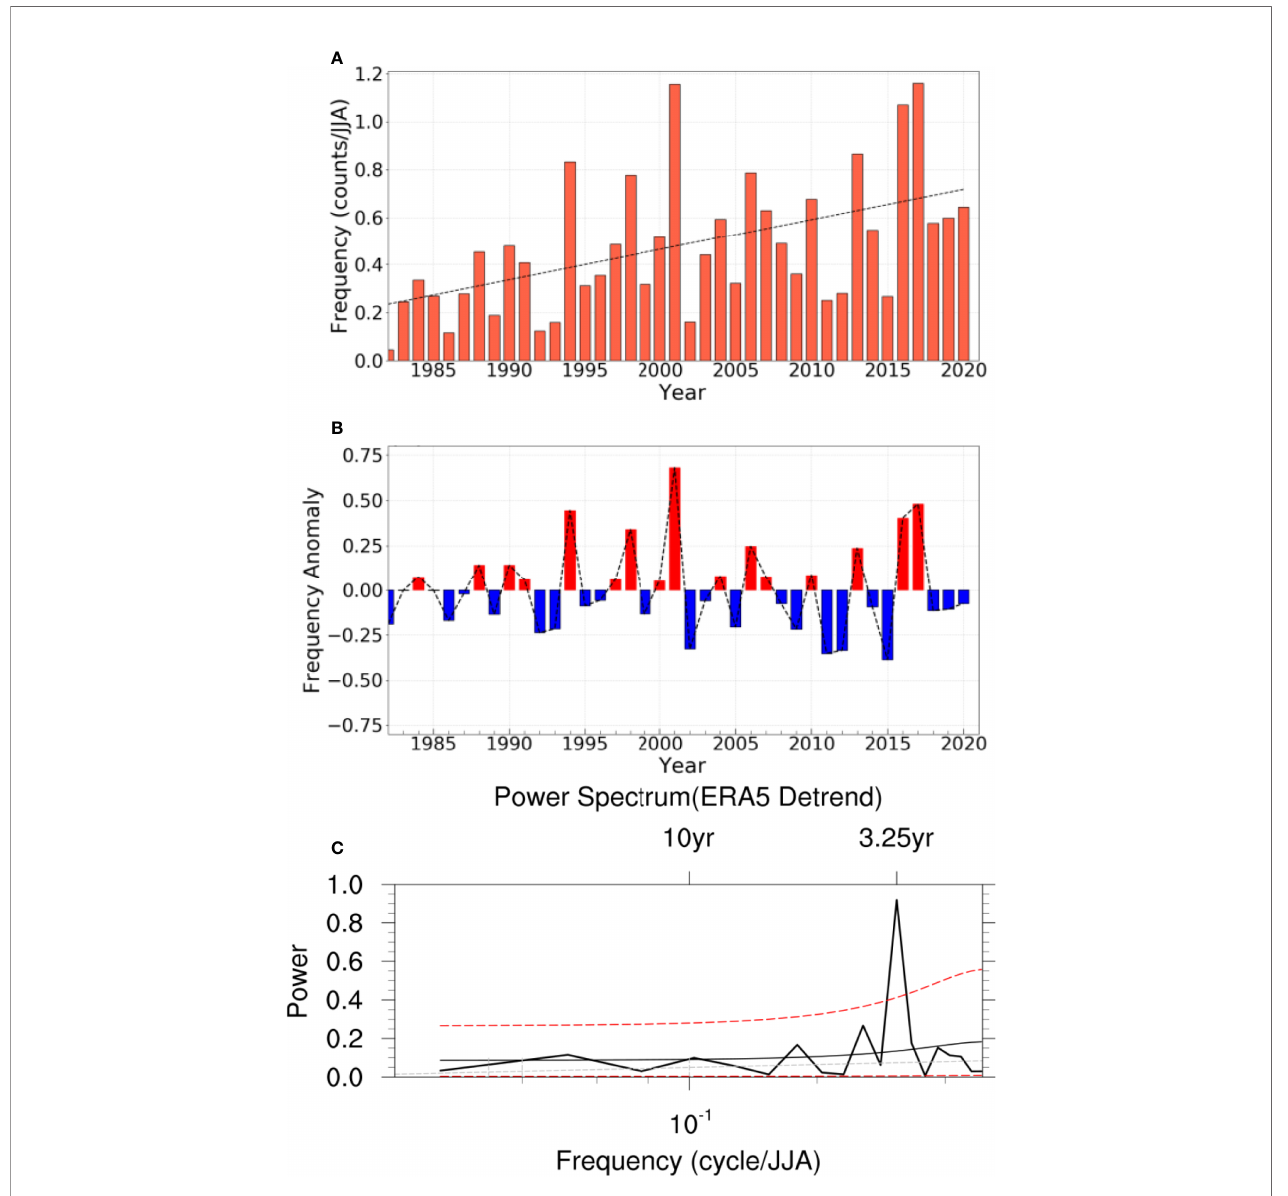
FIGURE 1 | (A) The total frequency time series of summer MHWs area-average in EAMS (115~135° E, 25~45°) with ERA5 reanalysis data from 1982 to 2020. The dotted line indicates a linear trend. (B) The total frequency time series as seen in (A) but with the linear trend removed. (C) Results of power spectrum analysis obtained from the total frequency of MHWs in EAMS during summer. The dotted lines above shown in the spectrum analysis fi gure indicate signi fi cant values at the 95% and 5% con fi dence level,